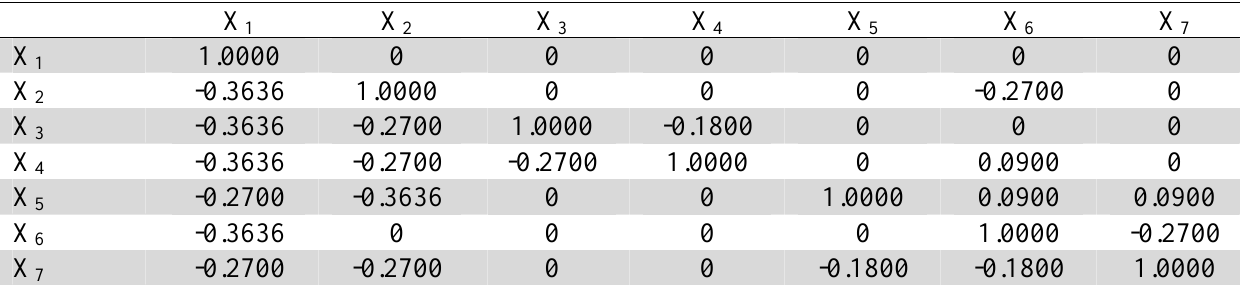
The summary of I-M matrix